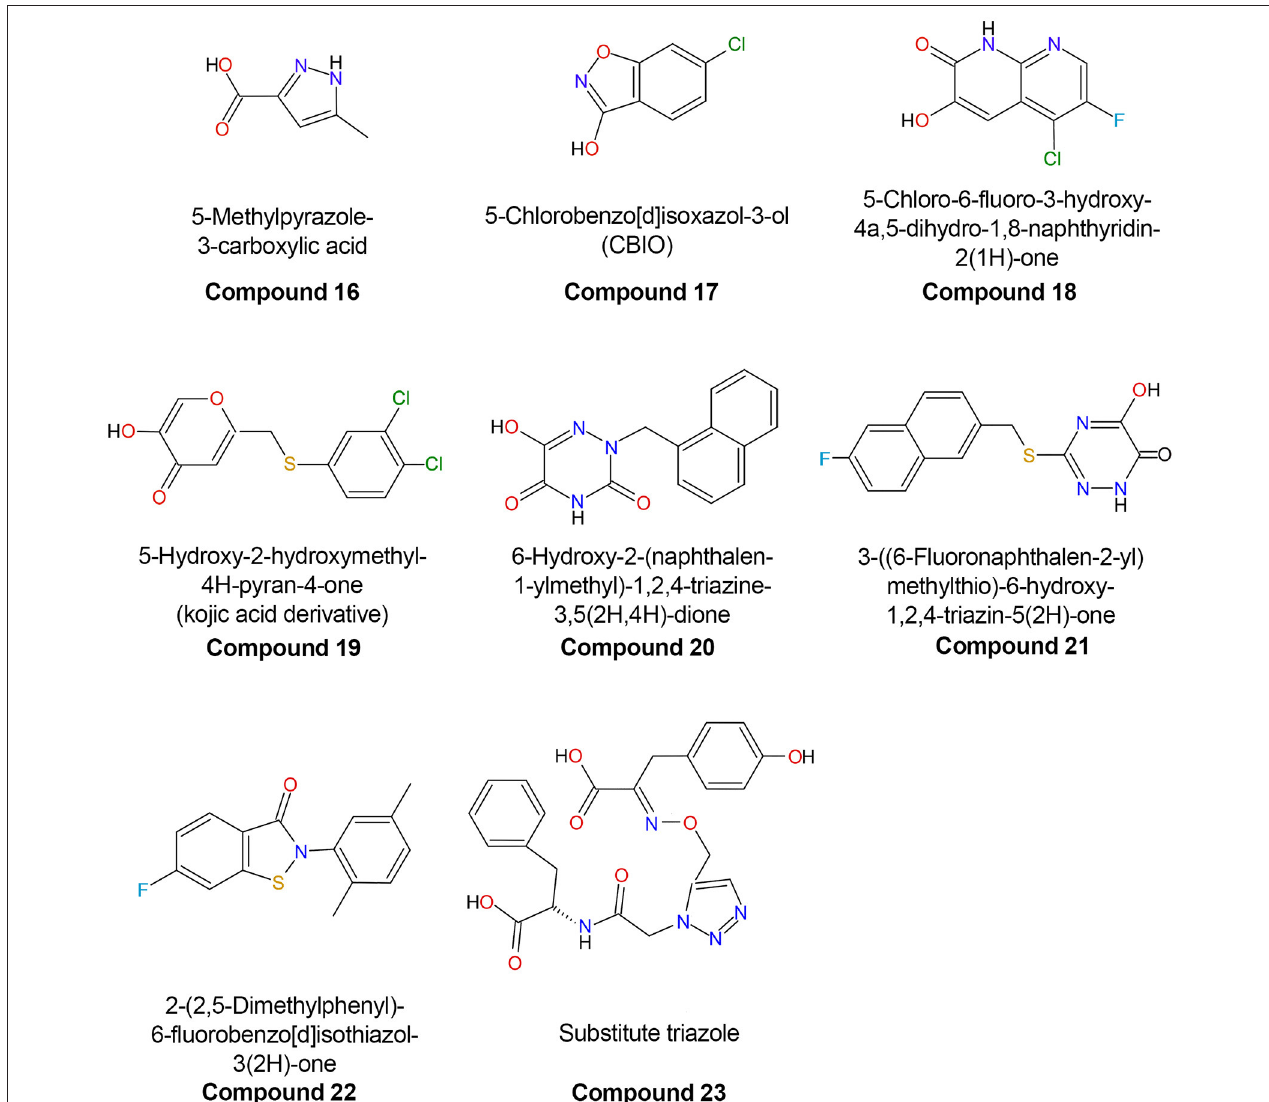
FIGURE 7 | Chemical structures of human D-amino acid oxidase inhibitors reported in Table 3 .